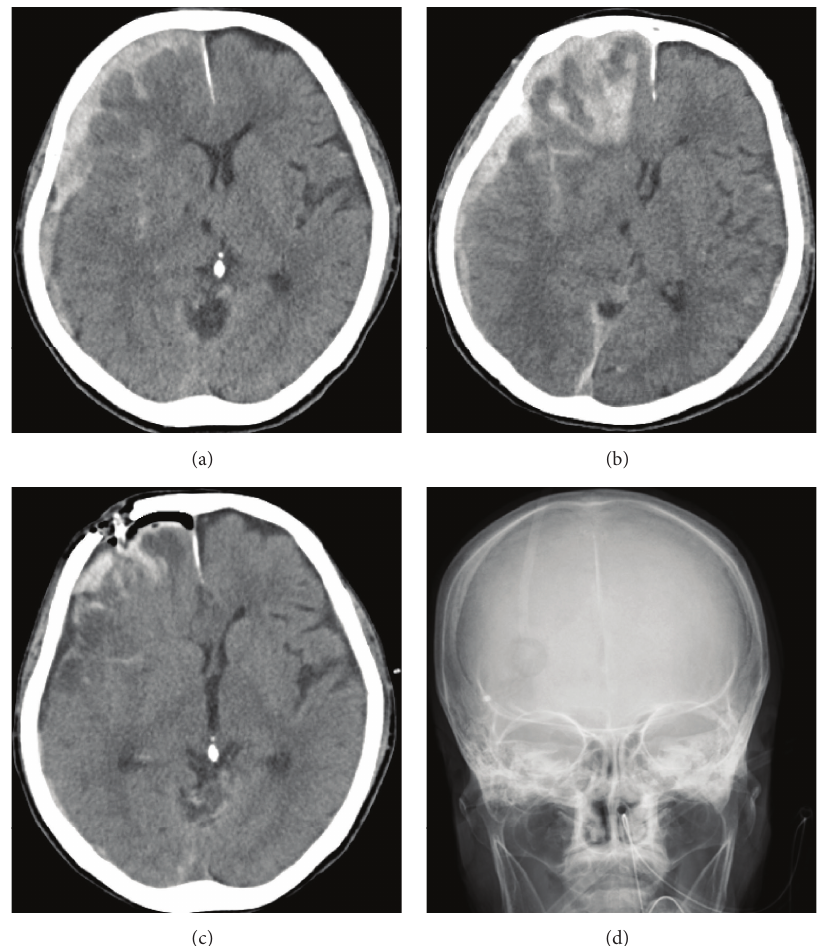
Figure 2: (a) Axial plain CT scan at the time of admission shows right acute subdural hematoma and right frontal and temporal contusion with thickness of 10mm and midline shift of 6 mm. There is a bruised area in the left temporal region without bone fracture. (b) Axial plain CT scan 48 hours after admission showed massive contusion and uncal herniation. The midline shift has worsened to 9 mm. (c) Most hematoma was removed and midline shift was completely resolved. The massive contusion in the right frontal lobe was reduced. The information drain was inserted into the subdural space. (d) Radiographic frontal view shows location of the burr hole 3 cm above the right